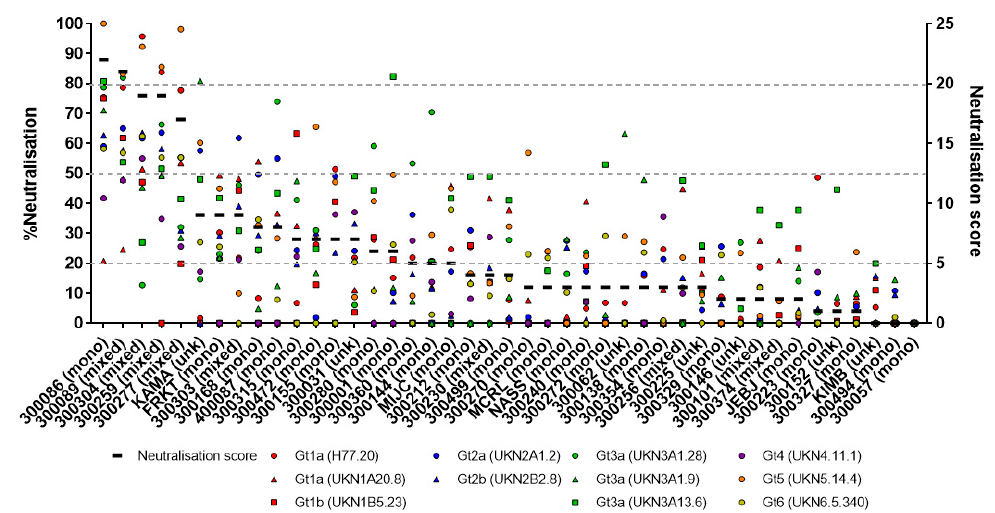
Figure 2. Individual analysis of the neutralisation activity against 11 HCVpp for the 43 subjects included in this study. Subject ID is indicated on the x axis, and infection history (mono-, mixed, or unknown [unk] infection, is indicated in parentheses). The neutralisation score (black line for each subject and right-hand y axis) applied for each subject (listed on the x axis) is observed to summarise both the breadth (multiple HCVpp neutralised) and neutralisation potency (left-hand y axis) of each HCVpp, representing an accurate summary of overall neutralisation potential. Each grey line represents the cut off for each part of the scoring system.